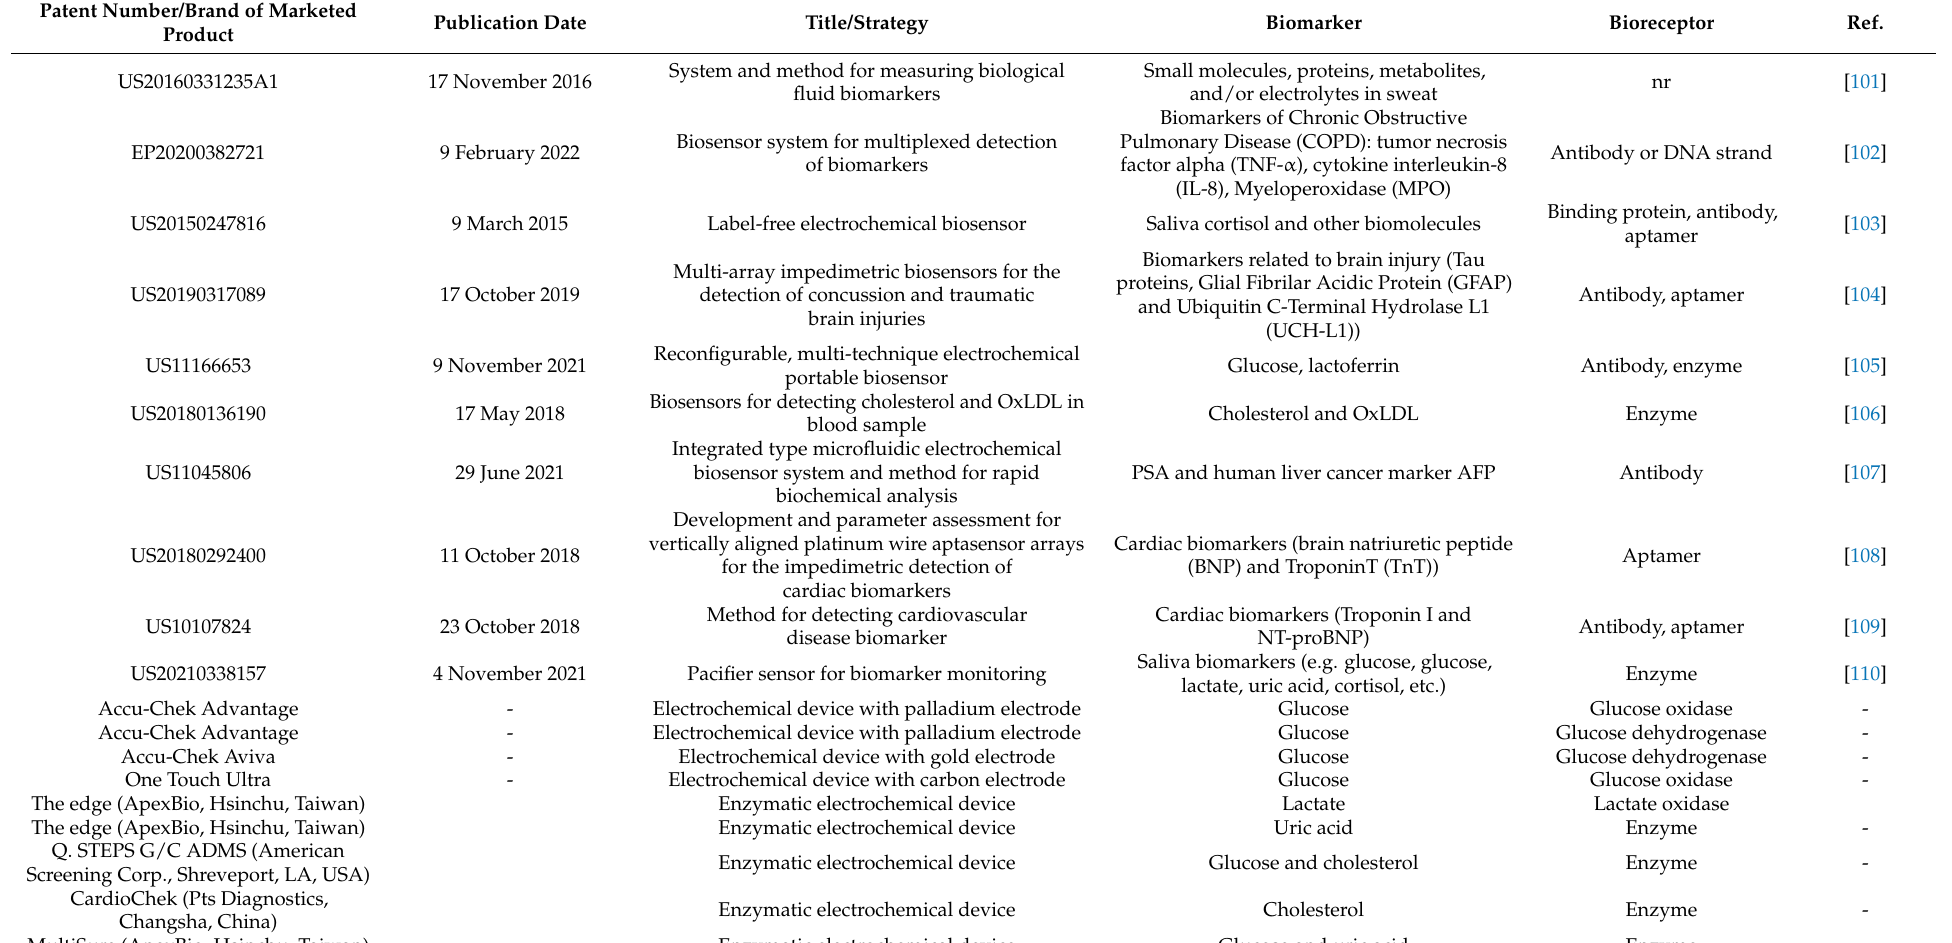
Table 7. Selected patents and marketed products related to the electrochemical biosensors for biomarker detection. Patent Number/Brand of Marketed